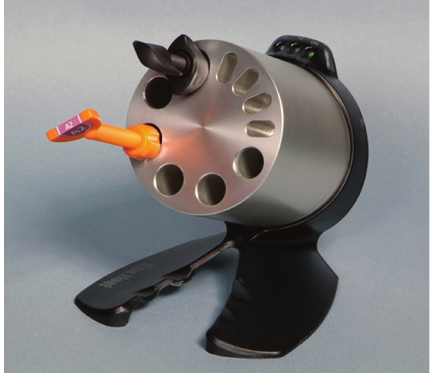
Figure 1: Composite warmer (Micerium